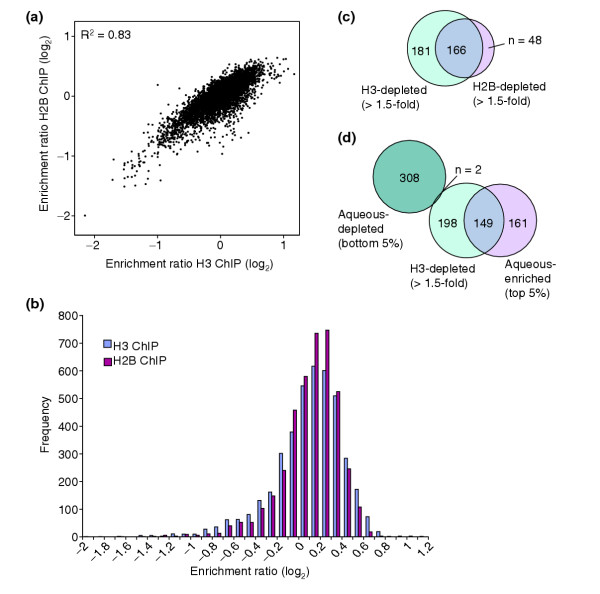
Correlation between H3 and FLAG-H2B ChIP datasets. DNA associated with histones in vivo was enriched in ChIP assays using antibodies against histone H3 or FLAG-H2B, and quantified by microarrays. (a) Relative enrichment of promoters and other non-coding regions in the H3 and H2B ChIP assays is shown. (b) Histogram showing distributions of enrichment for promoter regions in the H3 and H2B ChIP assays. (c) Overlap between regions depleted in the H3 and FLAG-H2B assays is shown. Overall, there is an 0.83 correlation between these ChIP datasets. (d) Overlap between regions depleted in the H3 ChIP assay and regions enriched by aqueous extraction is shown [62].